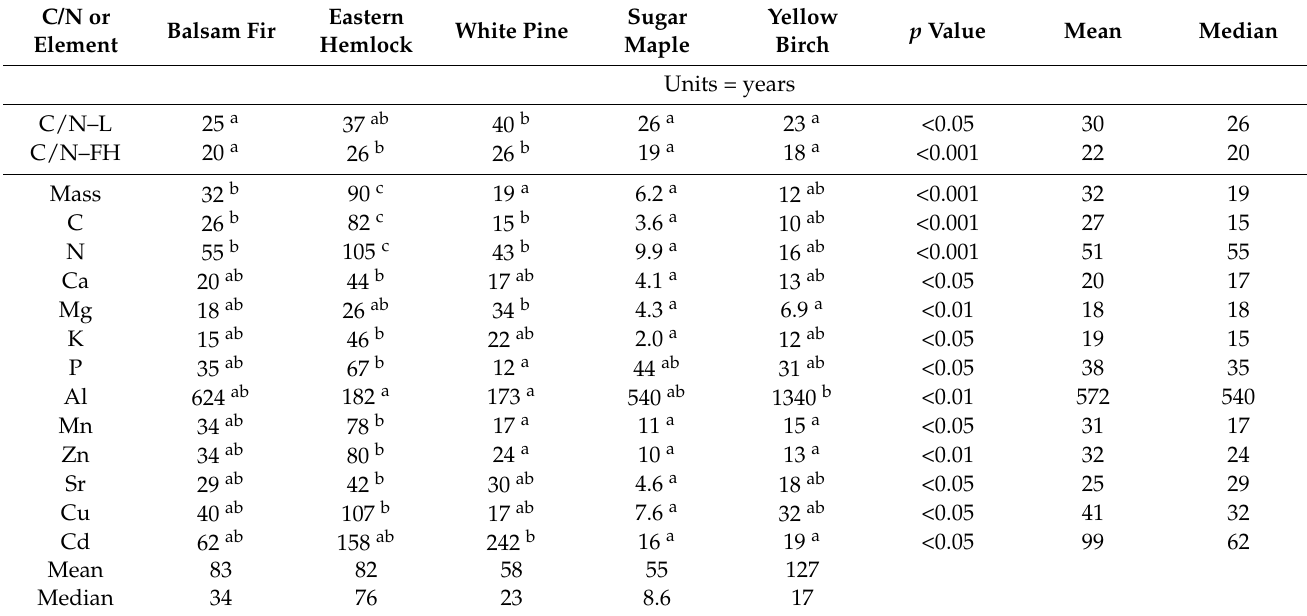
Table 4. Organic horizon C/N and residence times within the five stand types. Different letters represent significant differences among stands. For BF, EH, and YB, n = 3. For SM and WP, n =